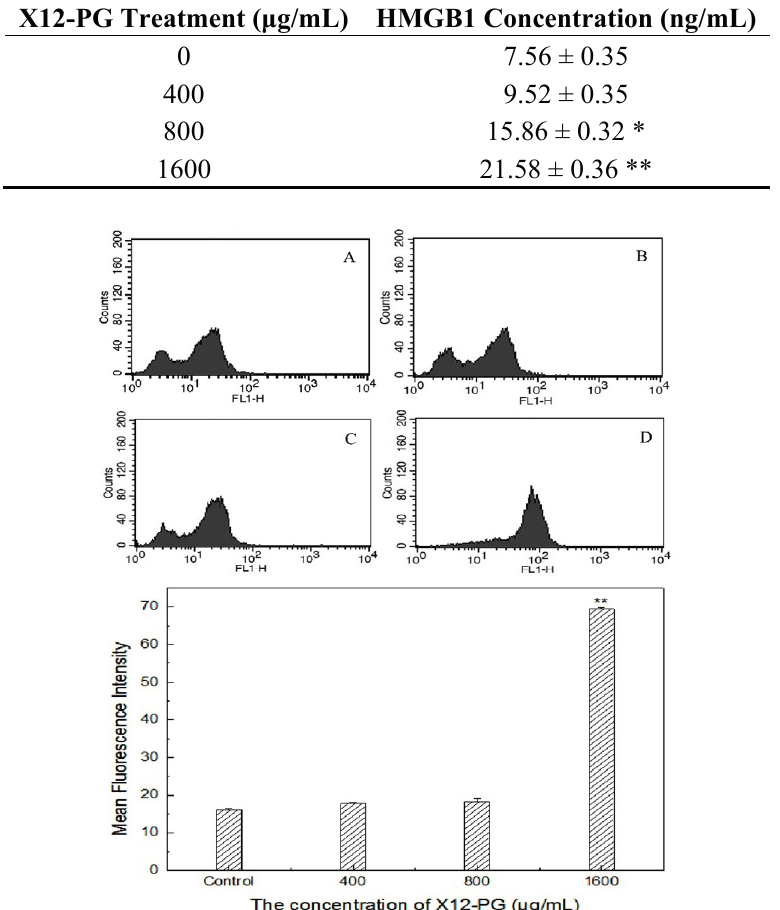
Table 3. ELISA detection of HMGB1 release in the supernatants of HT-29 cells.